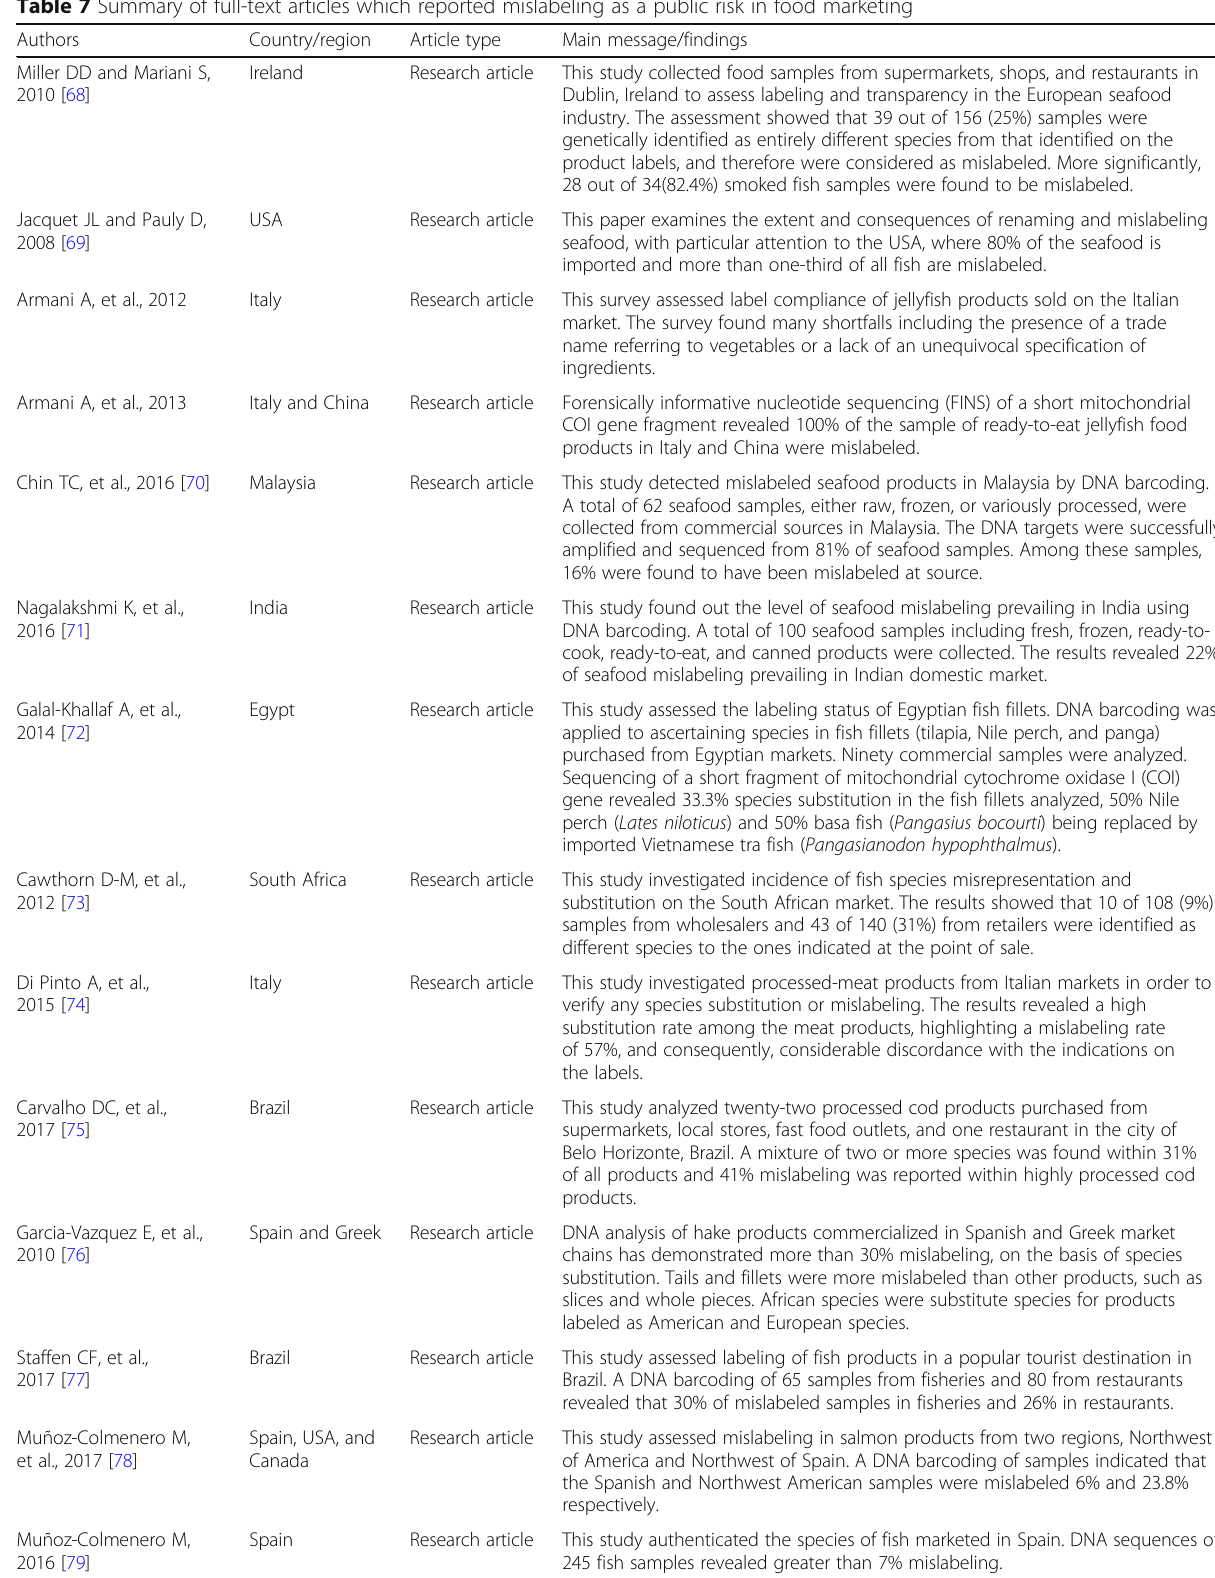
Table 7 Summary of full-text articles which reported mislabeling as a public risk in food